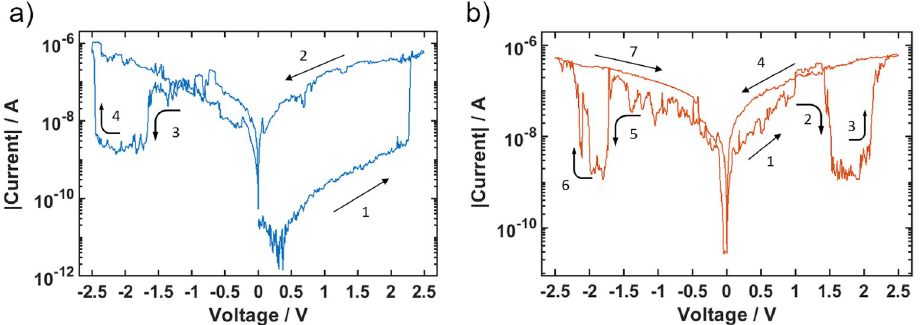
Fig 5. Reset behaviour with reverse voltage. a) Cycle starting in HRS. The LRS is retained until -1.5 V is applied. b) Subsequent cycle starting in LRS. The reset behaviour is symmetrical in the positive and negative voltage range. The numbers indicate in which order the resistive switching